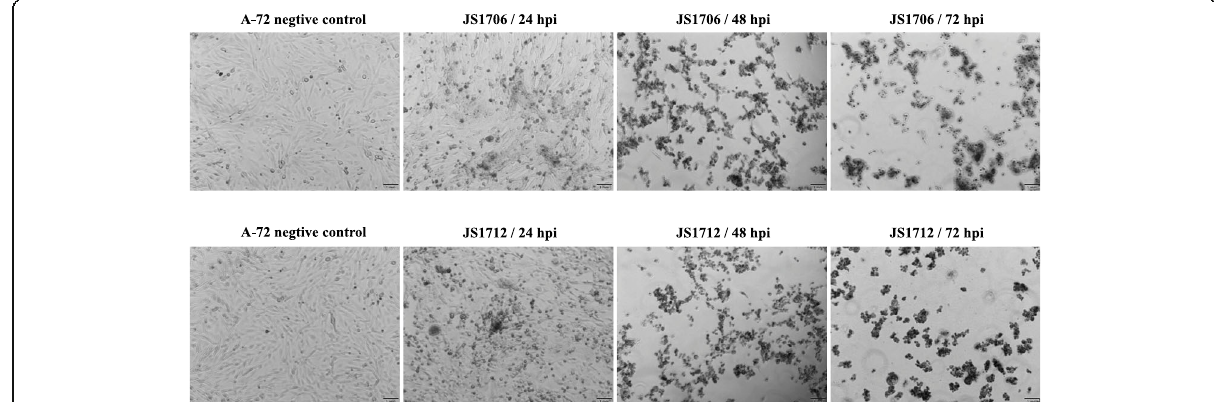
Fig. 2 Progression of cytopathic effects caused by CCoV in A-72 cells. The cytopathic effects of A-72 cells infected with CCoV JS1706 and CCoV JS1712 were monitored under microscopy at the indicated time points. Hpi, hours post inoculation. Scale bars, 1 mm